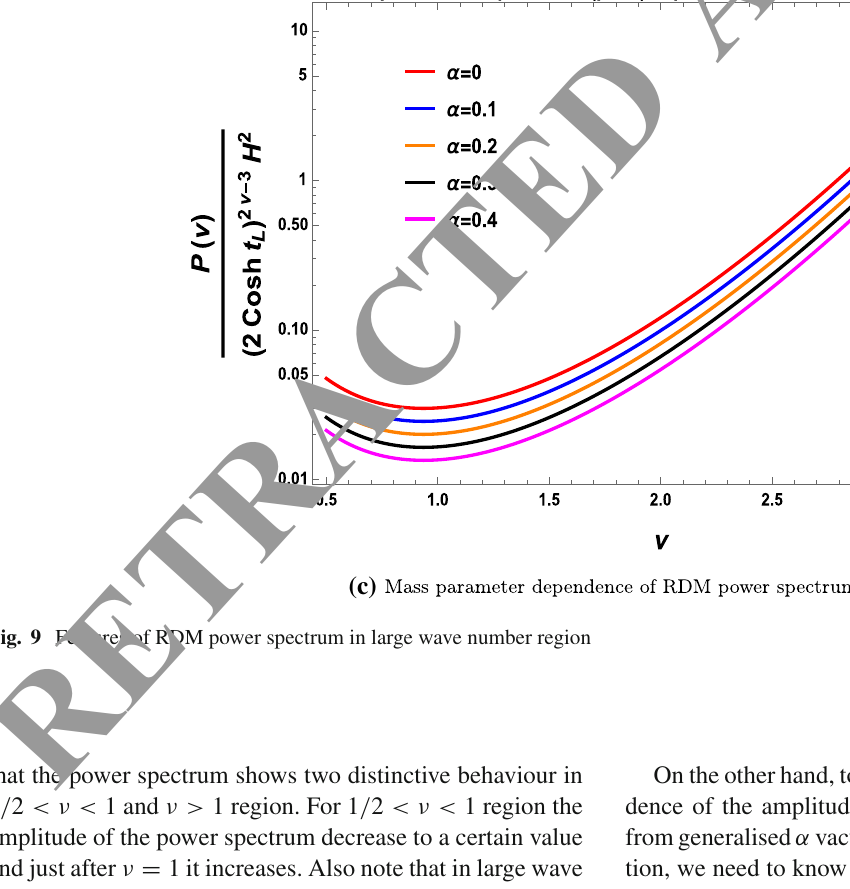
Fig. 9 Features of RDM power spectrum in large wave number region